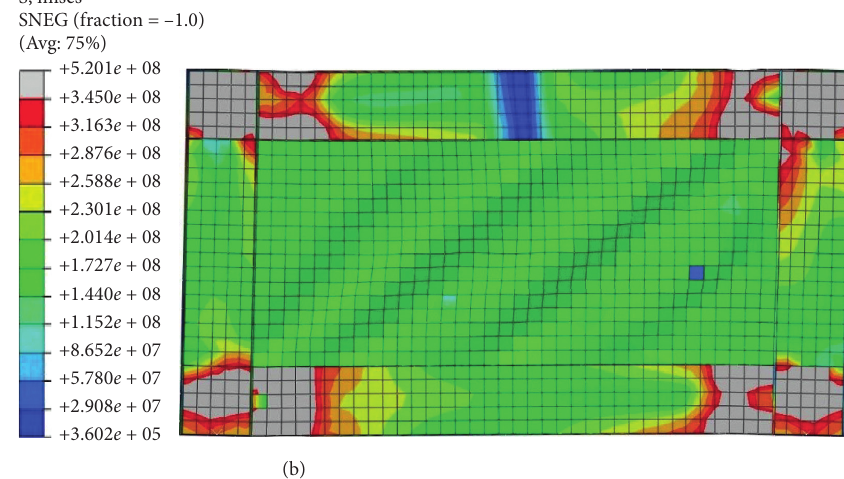
Figure 8: Comparison between experimental and computational results for von Mises stress at a drift of 3% for the SPSW tested by Vian et al. (a) Tested model. (b) FE model.